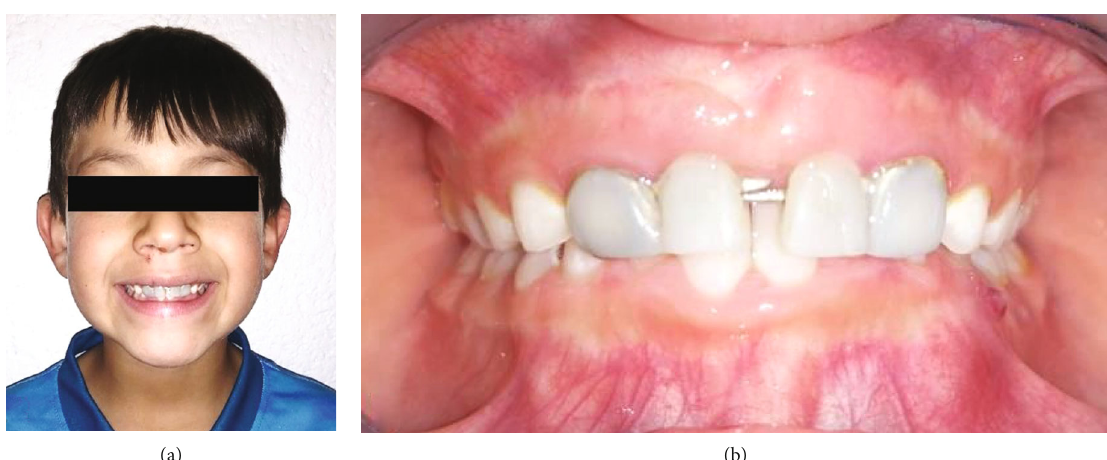
Figure 4: One-year control appointment. (b) clearly shows an increase in the interincisal spacing that was the resultant of transverse maxillary growth, which is the rationale of using this appliance